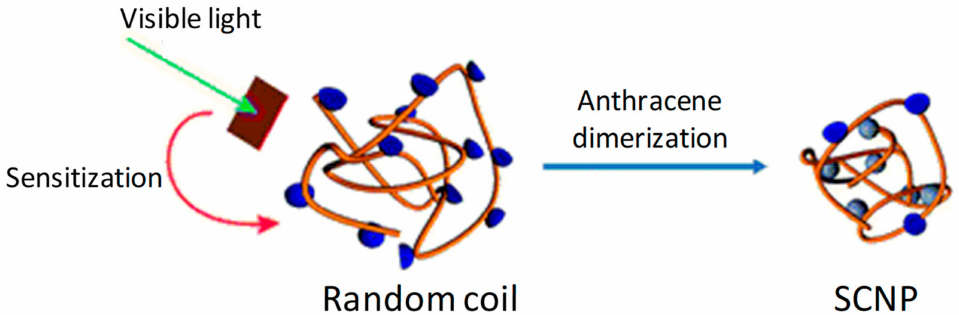
Figure 4. Schematic illustration of the synthesis of SCNPs through photochemical upconversion (also referred to as triplet–triplet annihilation upconversion) via intrachain dimerization of pendant anthracene groups under visible light irradiation ( λ = 532 nm) in the presence of platinum octaethylporphyrin as a sensitizer. Reprinted from [31] with